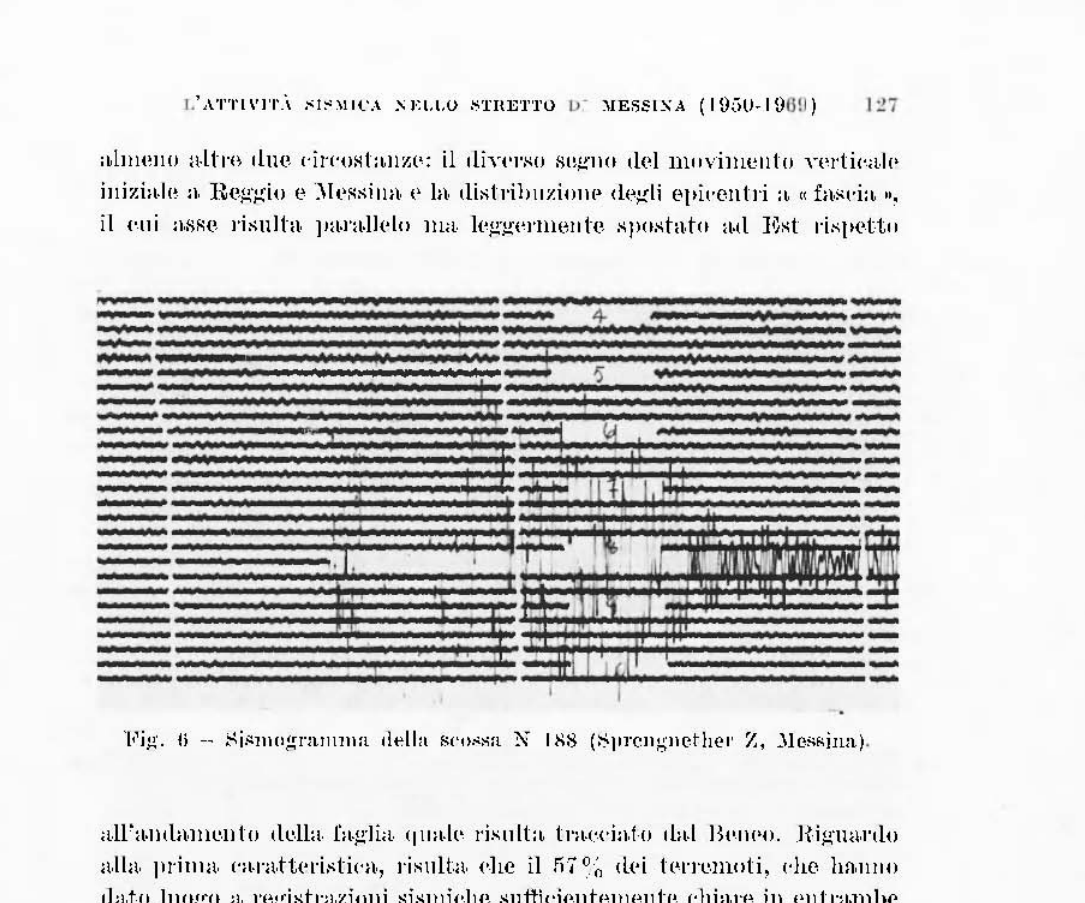
a.n':~llllallwllto Ile-lla. hg'lia, qw~l(' risllita tl'*·,('iato Ihl BI'lll'O, Hignu.J'Ilo H.llH, pr-inm (%l'H,ttNi,~Ii('a, ri~\11t.H, ('he il fi7 o~ (l{'i h'ITelllllli, ('he